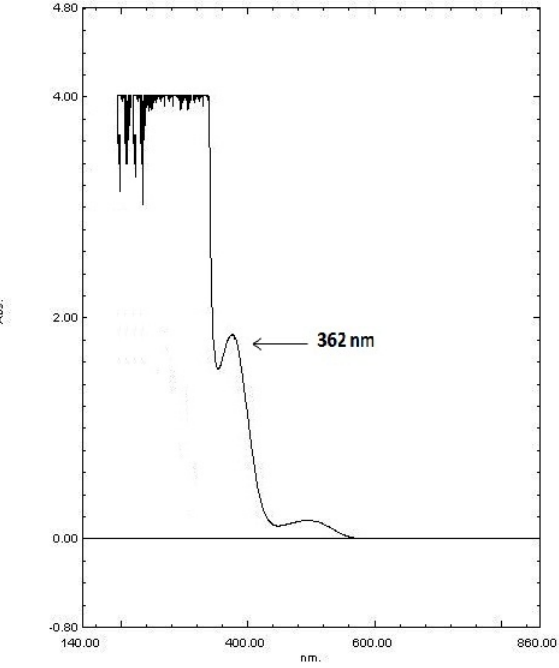
Fig. 4 UV–visible spectral scan of the quercetin